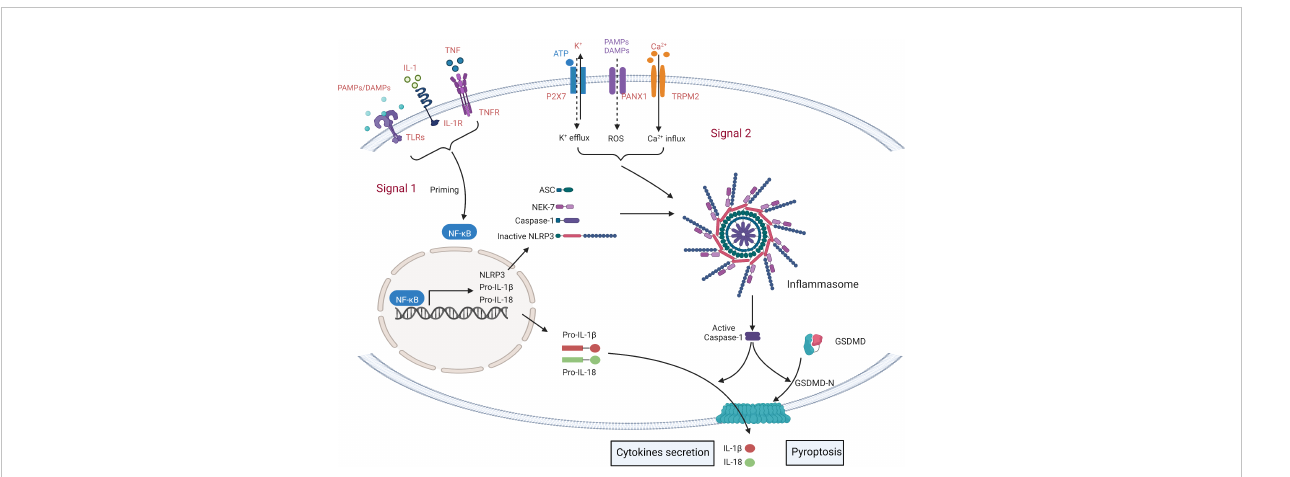
FIGURE 2 Simpli fi ed mechanisms for the canonical NLRP3- in fl ammasome activation. The formation of in fl ammasome requires two key steps: NLRP3 initiation signal and activation signal. The initiation signal is triggered by Toll-like receptors (TLRs) and cytokine recognition receptors that recognize PAMPs/ DAMPs and cytokines (including IL1, TNF). These signals induce the transcription of NLRP3, pro-IL-1 b , pro-IL-18 and pro-Caspase1 through NF- k B. Secondary signals are triggered by a wide range of stimuli, including K + ef fl ux, Ca 2+ in fl ux, phagocytosis of microbial and particulate matter (leading to destabilization/rupture and release of lysosomal cathepsins and reactive oxygen species (ROS)), and Mitochondrial dysfunction. Then, a multi- protein complex composed of NOD-like receptor protein, ASC and pro-caspase-1 is activated to activate the NLRP3 in fl ammasome, triggering the release of IL-1 b and IL-18 and cell